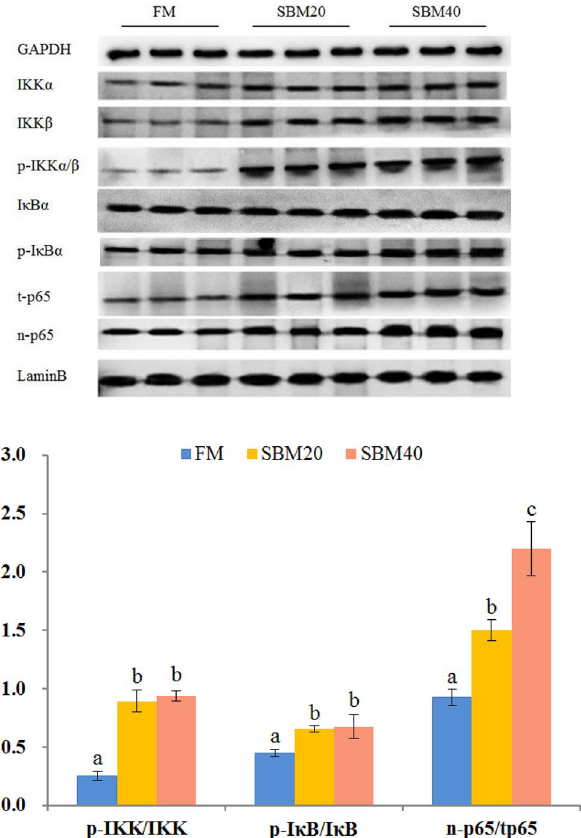
Figure 13. Western blotting analysis of activation of NF-κB signaling pathway in the hindgut of pearl gentian grouper fed by different substitution levels of soybean meal (n = 4). Note: Different letters assigned to the bars represent significant differences between the groups at P < 0.05. the The blots were cut prior to hybridisation with antibodies during blotting. GAPDH and LaminB were selected as the total protein and nuclear protein internal parameters, respectively. IKKα/β,inhibitor of IKKα/β kinase α/β; p-IKKα/β, phosphorylation inhibitor of nuclear factor kappa-B kinase α/β; IkBα, inhibitor of NF-κBα; p-IkBα, phosphorylation inhibitor of NF-κBα;